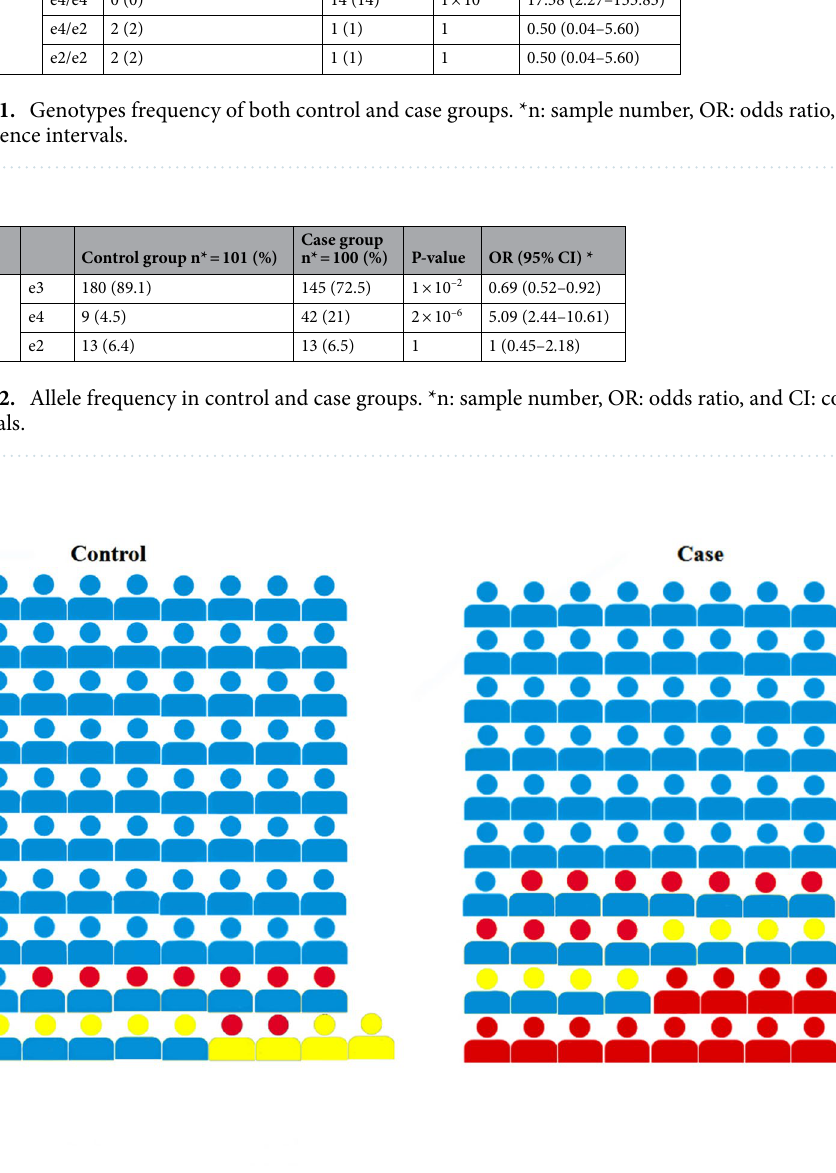
Figure 1. Schematic comparison of genotypes between control and case